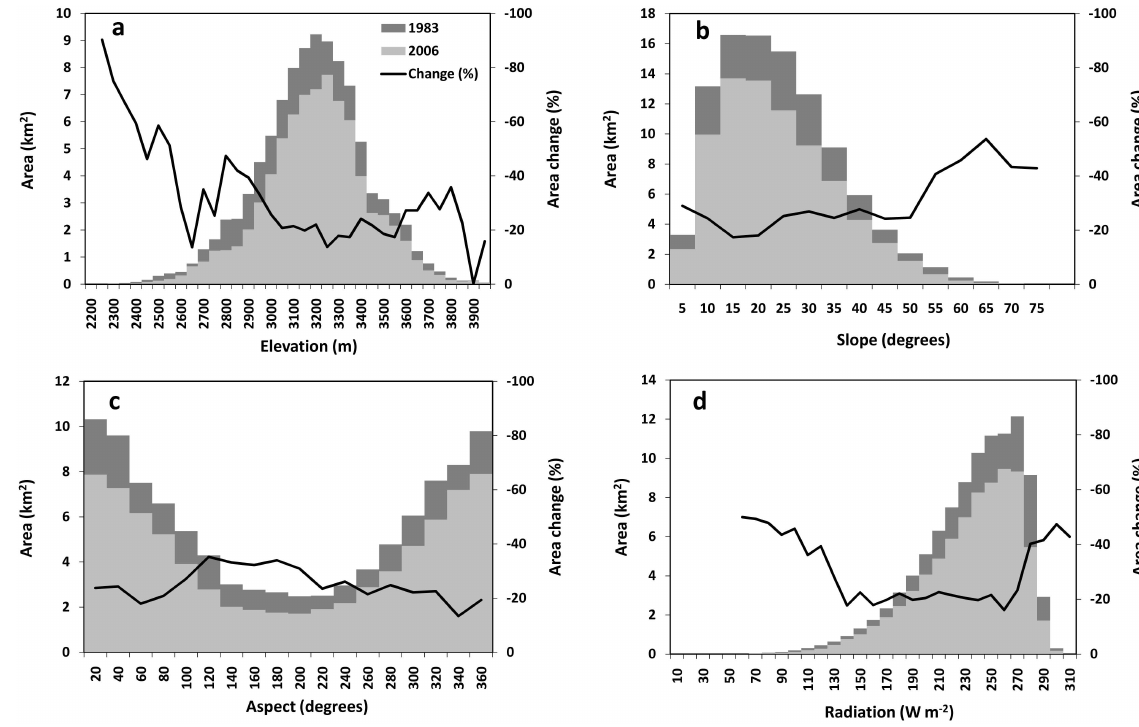
Fig. 8. Area distribution of the Ortles-Cevedale glaciers from 1987 to 2009 and percent change for classes of (a) elevation, (b) slope, (c) aspect, and (d) summer clear-sky